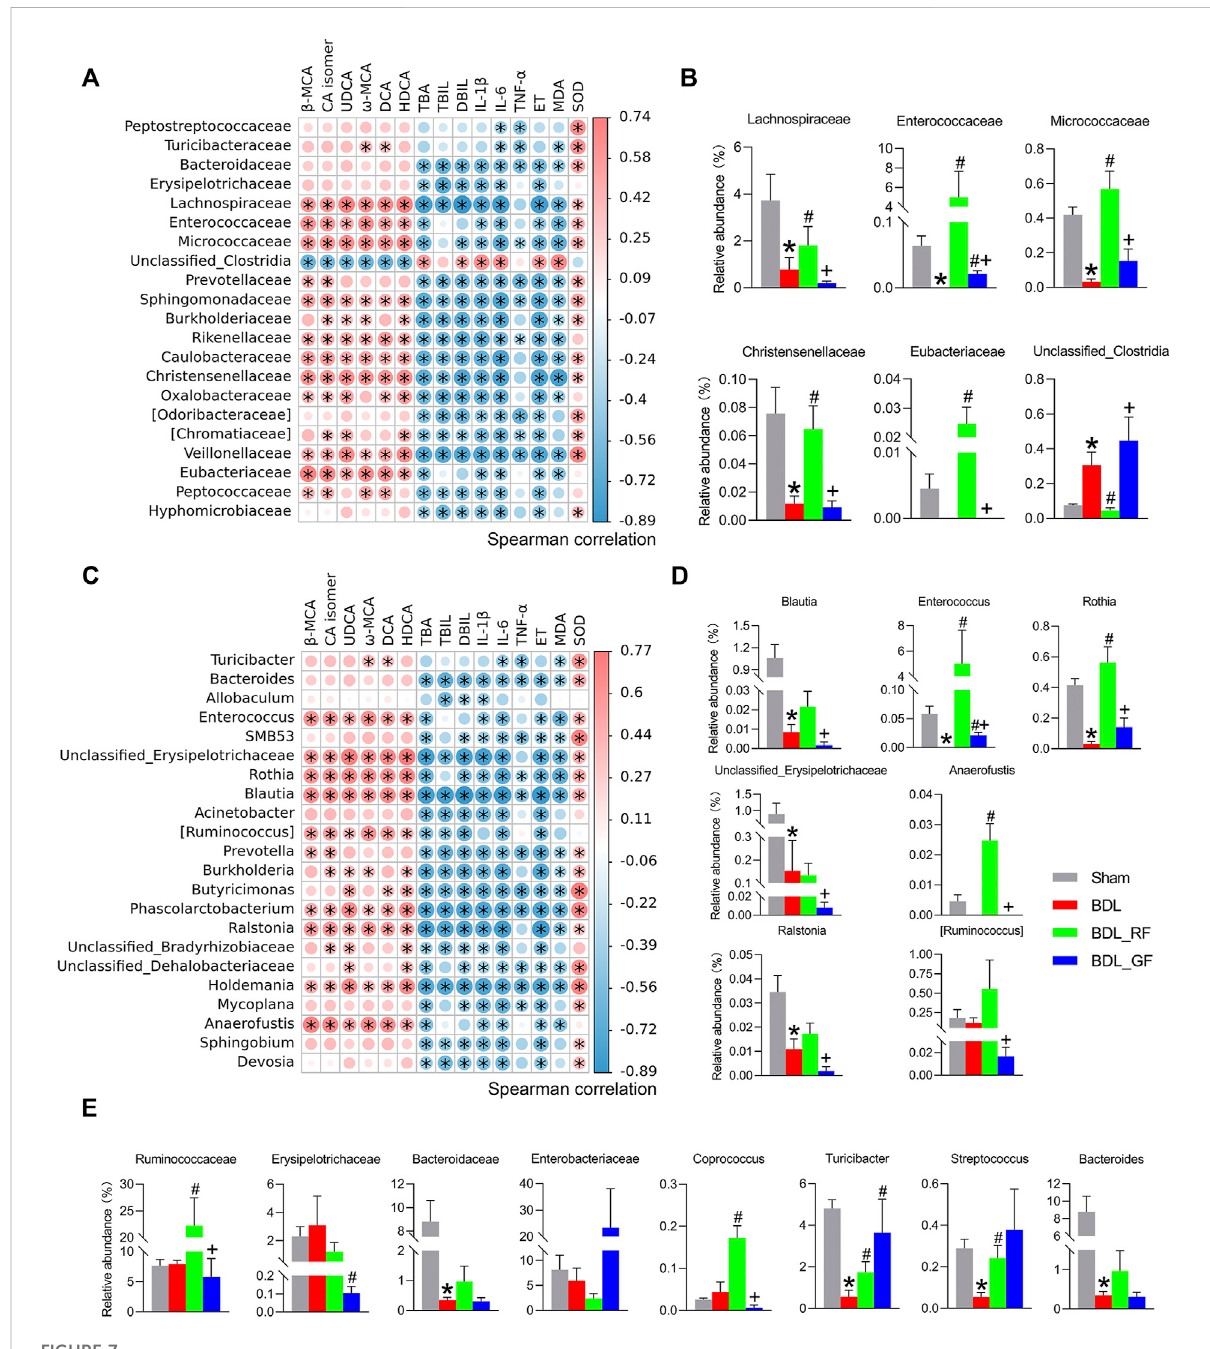
FIGURE 7 Bacteria potentiallyassociatedwithbileacidsmetabolismand diseaseprogression. (A , C) HeatmapsofSpearmancorrelationsbetween bacteria andentericbileacids,serumbiochemicalindicators,andliveroxidativestressatthefamilyandgenuslevels.Theheatmapwascreatedbasedondata on bacterial abundance and enteric bile acids, serum biochemical indicators, and liver oxidative stress levels. A Spearman correlation coef fi cient close to 1 ( > 0.6) indicates a strong positive correlation, while a Spearman correlation coef fi cient close to − 1 ( < − 0.6) indicates a strong negative correlation. (*: p < 0.05, n = 6). (B , D) Bacteria with intergroup differences in relative abundance among those screened by Spearman correlation analysis atthefamilyandgenuslevels. (E) Intergroupdifferences intherelativeabundanceofotherimportant bacteriaatthefamily andgenuslevels. (*: p < 0.05, compared with the Sham group; #: p < 0.05, compared with the BDL group; +: p < 0.05, compared with the BDL_RF group, n =